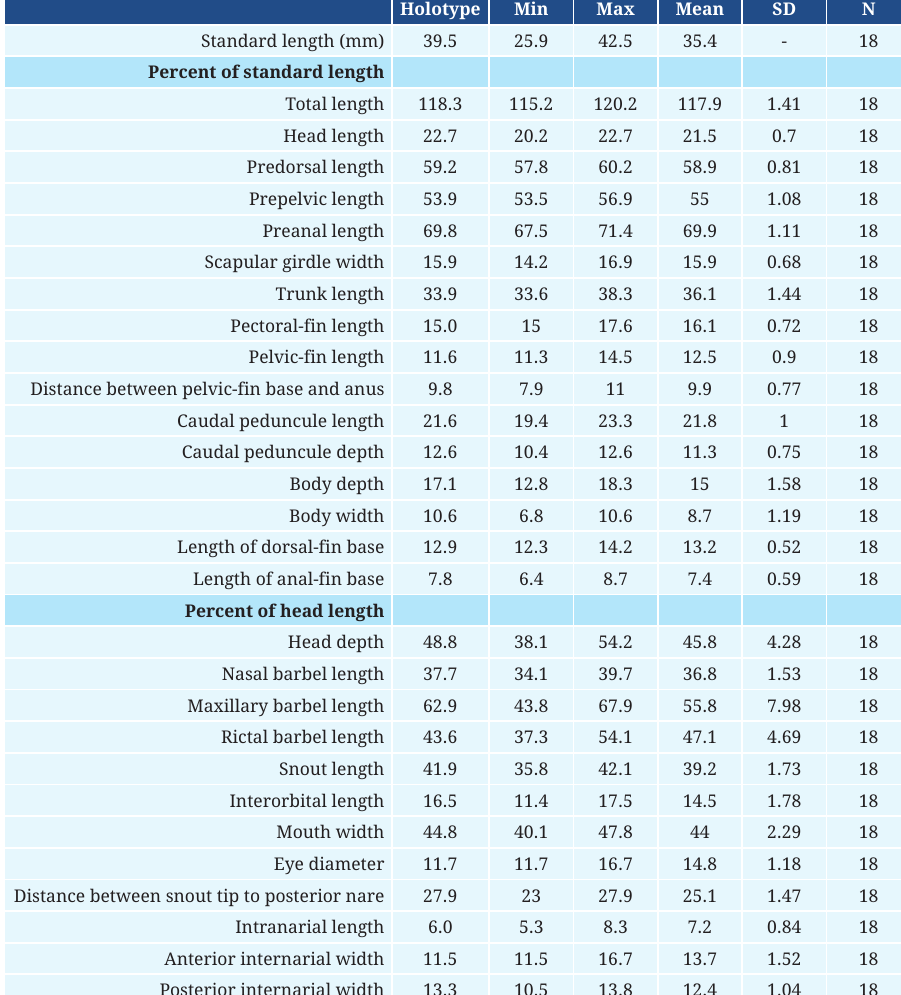
TABLE 4 | Morphometric data of Scleronema ibirapuita , new species (data of holotype included in the range). N = number of specimens; SD = standard